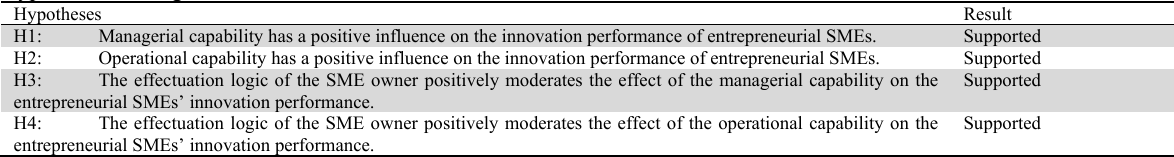
Hypothesis Testing Results